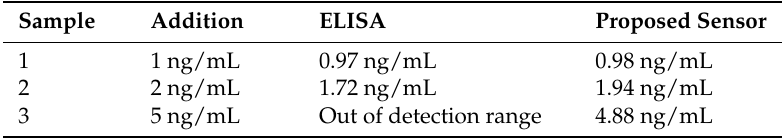
Table 1. Comparison of electrochemical immunosensor and the enzyme-linked immunosorbent assays (ELISA) method for the determination of ProGRP in serum